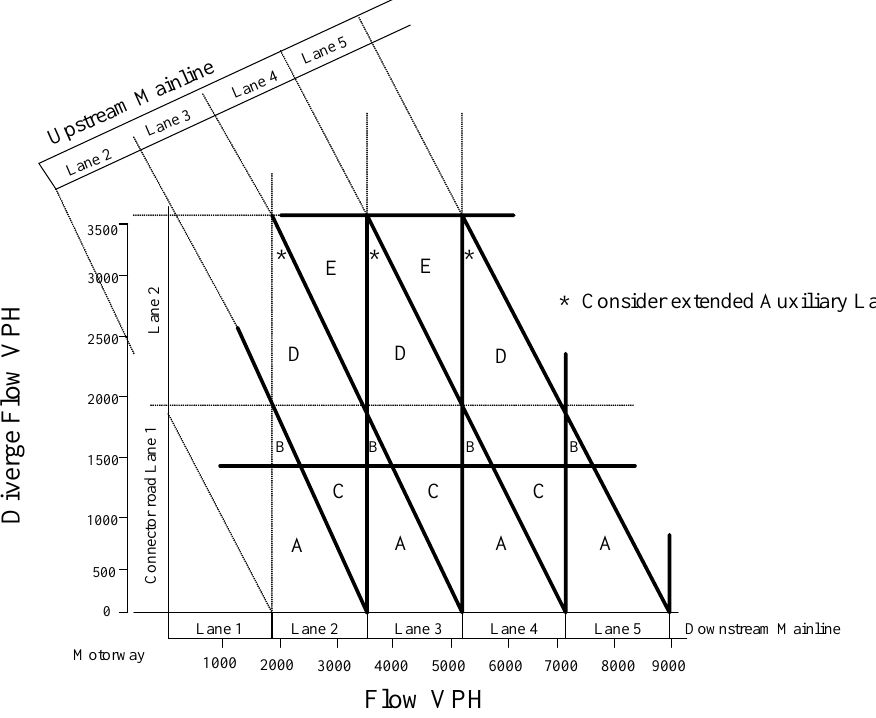
Figure 2. The diverging flow-region diagram from